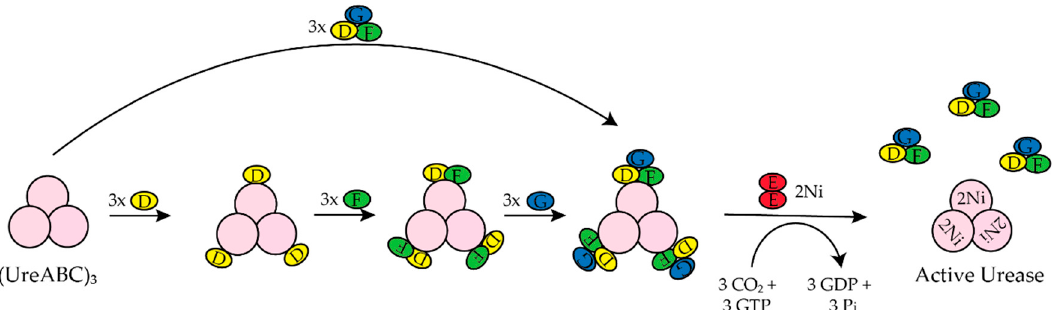
Figure 2. A simplified scheme of K. aerogenes urease activation [20,27,28]. The trimer of trimers (UreABC) 3 sequentially binds UreD, UreF, UreG or the UreDFG complex. The isolated UreDFG complex contains two UreD, UreF, and UreG promoter but only one monomer is shown for simplicity. Lys 217 is carbamylated by CO 2 , GTP is hydrolyzed by UreG, and nickel is delivered by UreE to form the active enzyme and the UreDFG proteins are released.